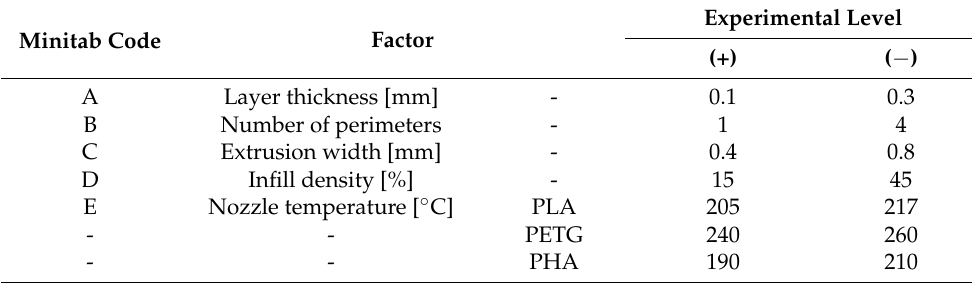
Table 1. Selected controllable factors and levels.